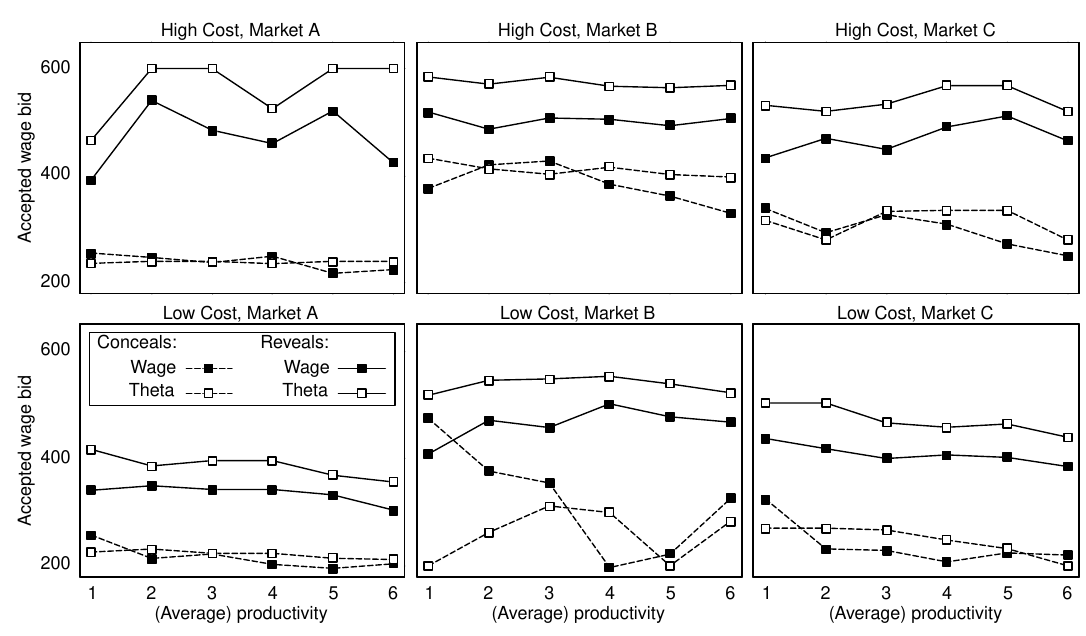
Figure 6. Equilibrium consistency of workers’ revelation decisions over